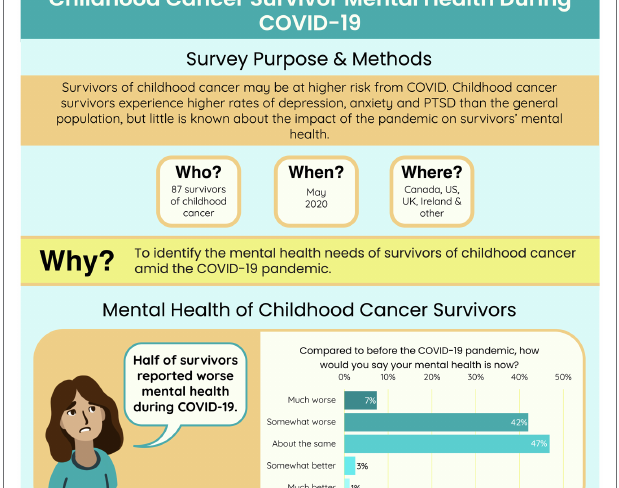
TABLE 4 | COVID-19-related information needs of AYA survivors.